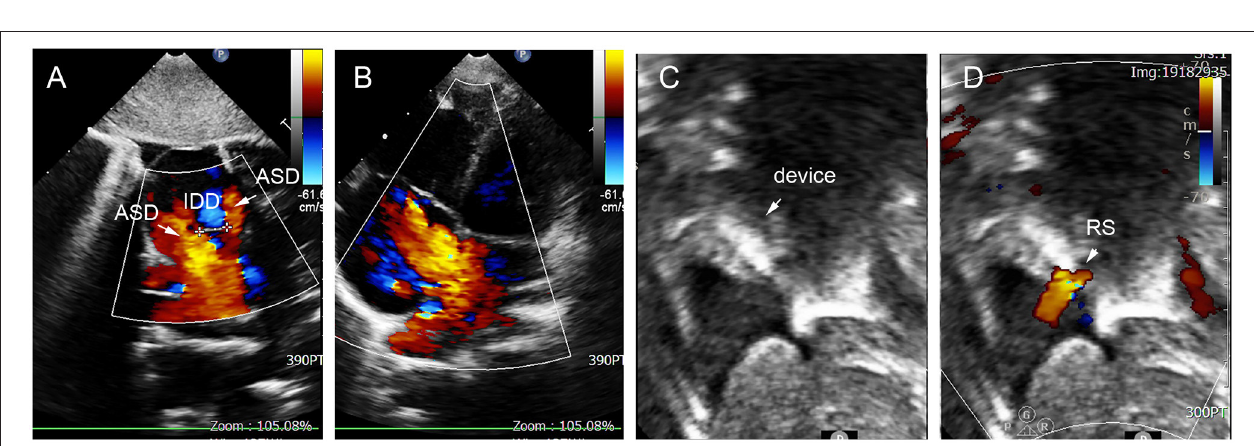
FIGURE 12 | ASA in 3-year-old girl had 18 mm aneurysm base, and double defects on the aneurysm with the IDD = 9mm (A,B) , remaining small residual shunt at 36-month follow-up (C,D) . ASD, atrial septal defect; IDD, inter-defects distance; RS, residual